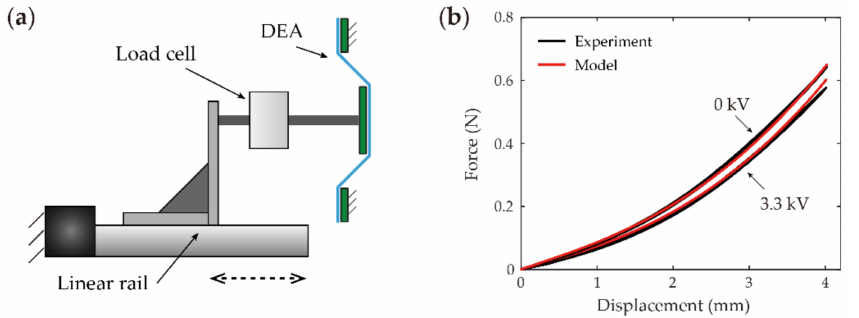
Figure 4. ( a ) Experimental setup of the quasi-static force-displacement characterization and ( b ) comparison of the experimental and modelling force-displacement results.